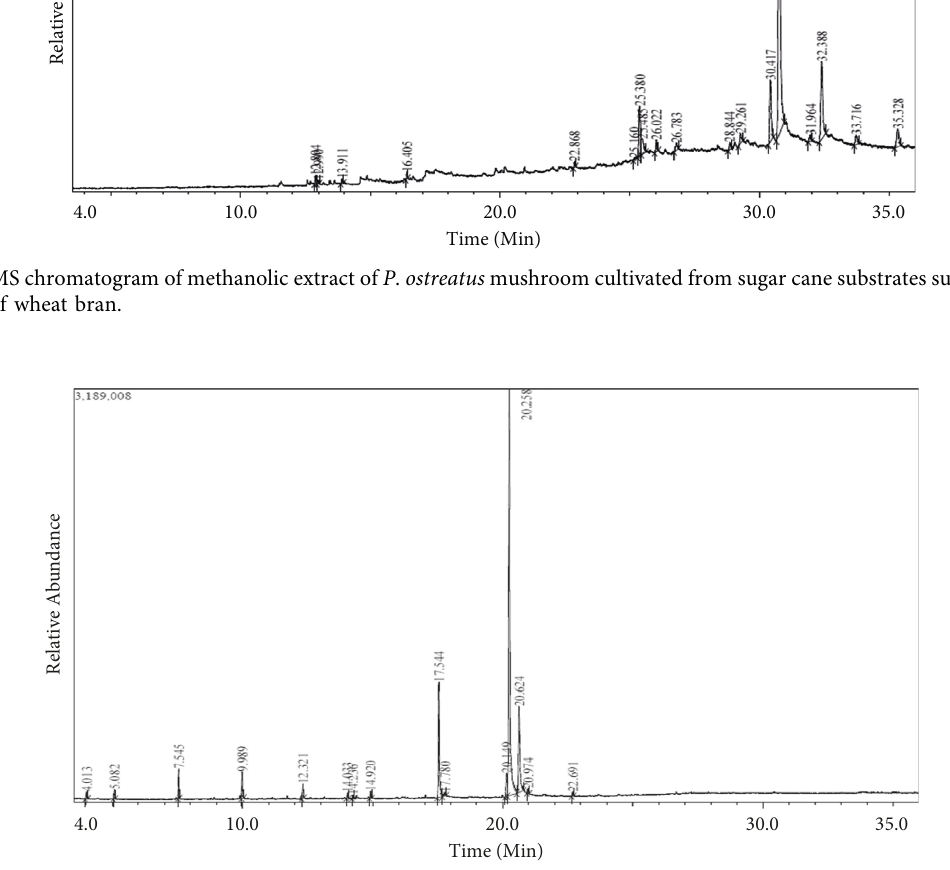
Figure 4: GC-MS chromatogram of methanolic extract of P . ostreatus mushroom cultivated from sugarcane bagasse supplemented with various levels of wheat